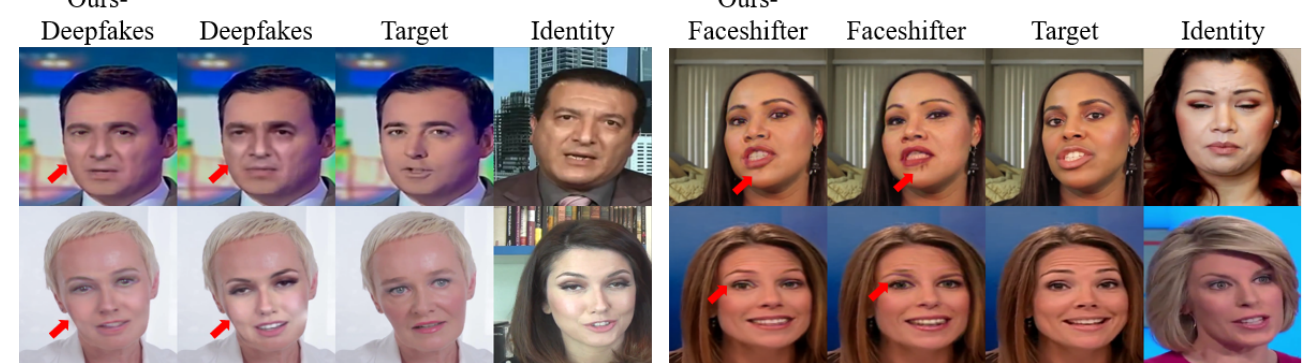
Figure 1. Previous methods suffers from two main problems in frame-level. First, they cannot inherit whole pose information from target image, i.e., gaze direction deviation. Besides, they cannot generate harmony results in complex environments, i.e., shadow